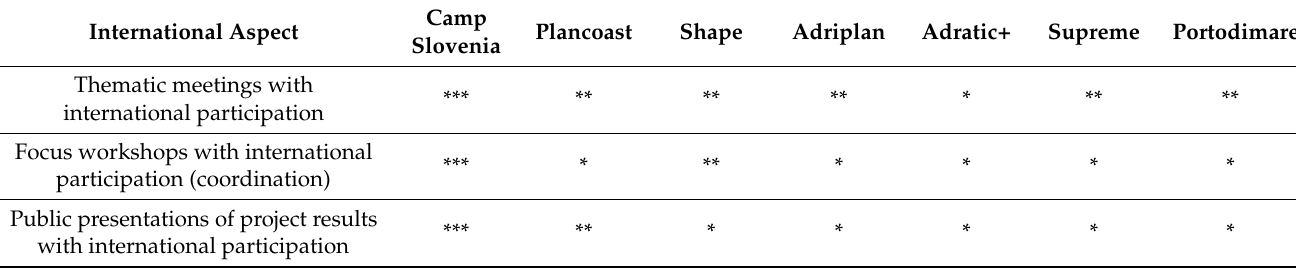
Table 10. Number of events with international participation in individual projects.